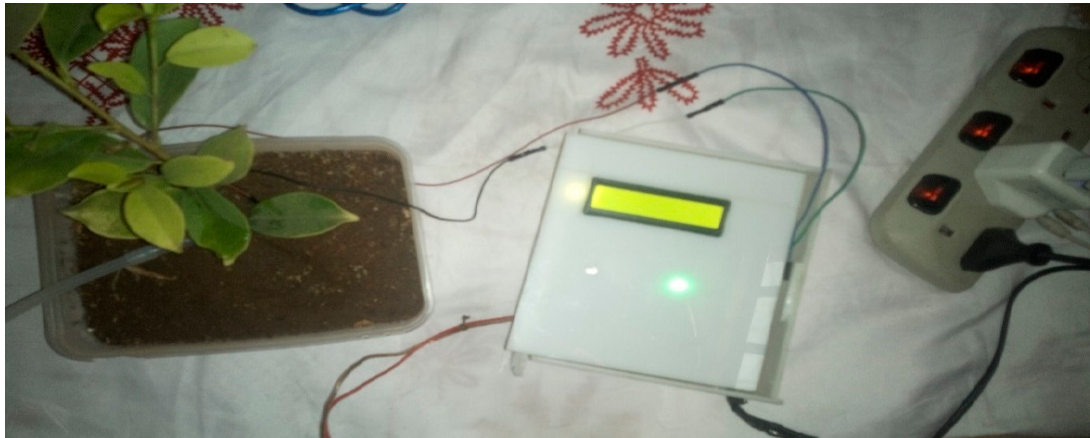
Figure 10. Prototype testing in less dry soil (Moisture level 17%).